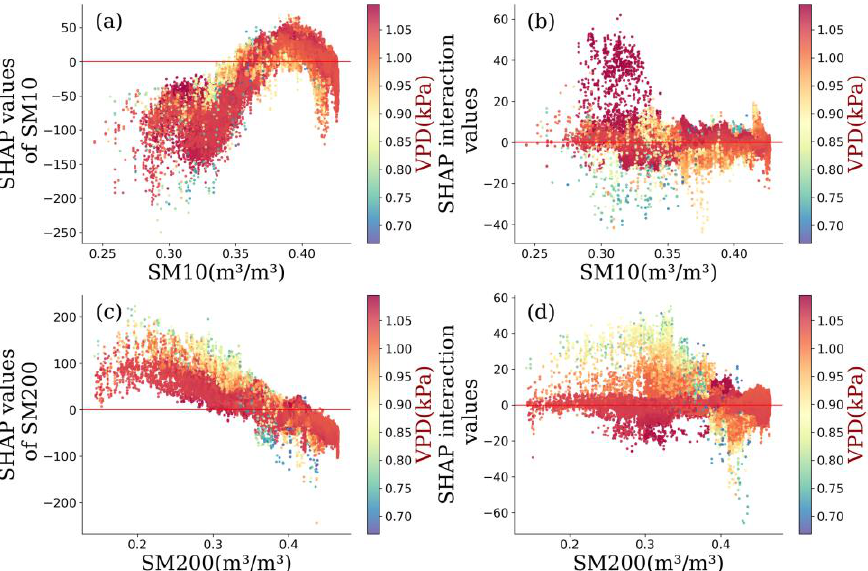
Figure 8. Coupling effect and interaction effect between soil moisture content and vapor pressure deficit. Units of SHAP and SHAP interaction values: g C/m 2 : ( a ) Coupling effect between SM10 and VPD. ( b ) Interaction effect between SM10 and VPD. ( c ) Coupling effect between SM200 and VPD. ( d ) Interaction effect between SM200 and VPD.